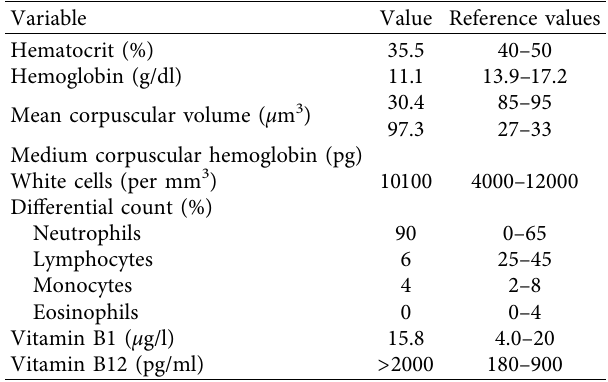
Figure 4: Histopathology of a biopsied subcortical lesion of the right frontal lobe (hematoxylin and eosin staining). (a) The bottom of the image shows normal eosinophilic white matter and demyelinated tissue at the top. (b) Magnification of demyelination zones with macrophage infiltration. Table 2: Blood chemical values after